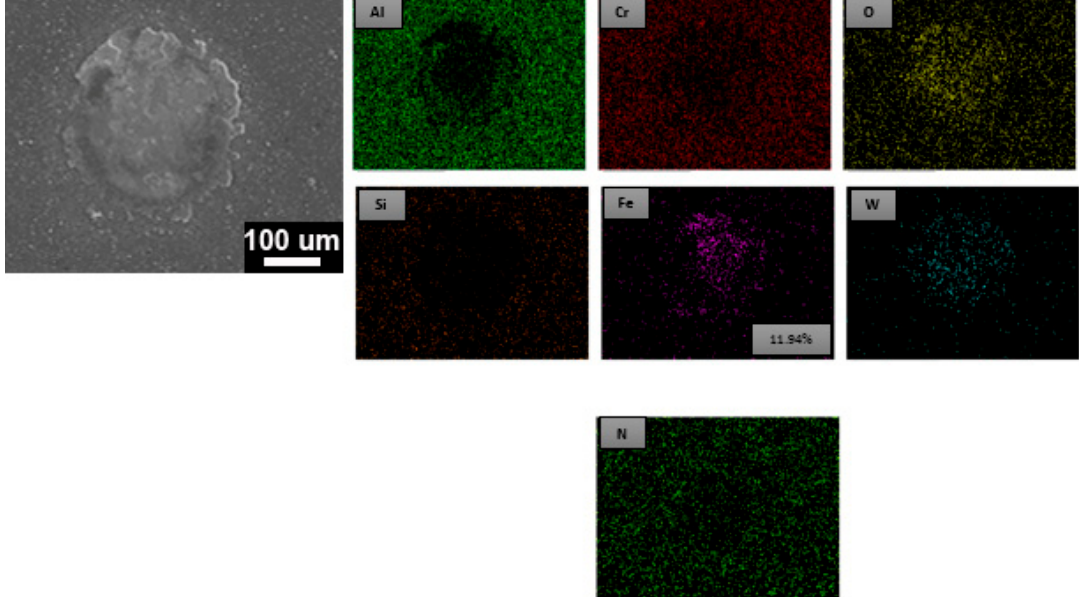
Figure 10. SEM and EDS element mapping of PN + AlCrSiN at high temperature (500 °C) after 400k impacts.